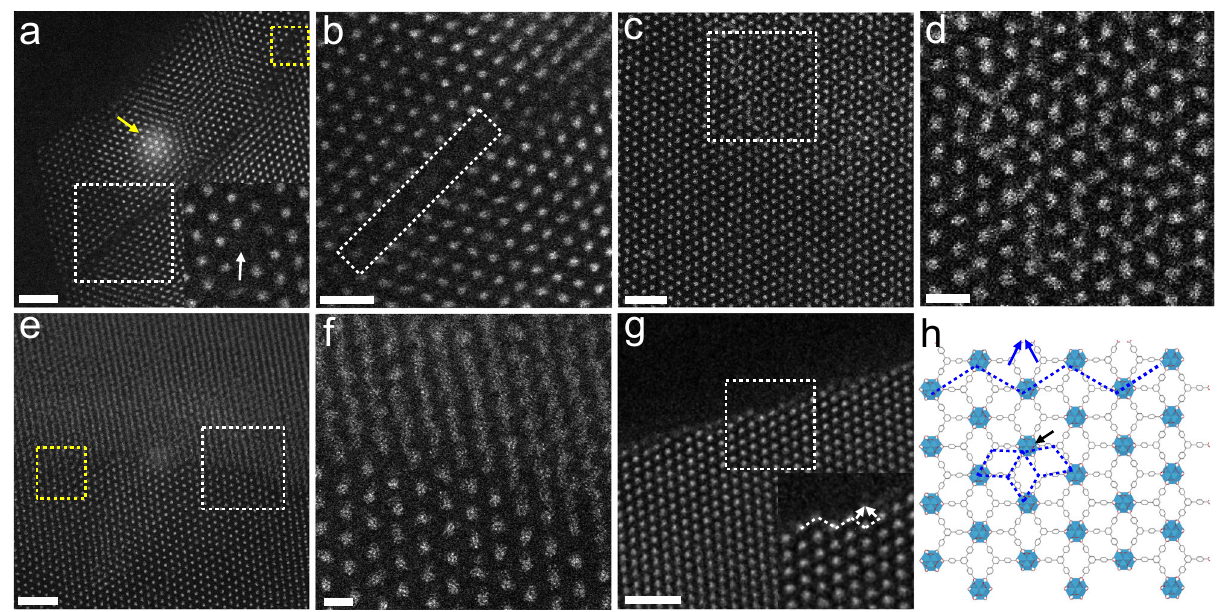
Fig. 3 | Revealing local structures of Hf-MOLs using HAADF-STEM. a HAADF- STEMimage ofMOLsshowsthemissing-clusterregions.Theinsetistheenlarged region of the yellow frame, which shows one cluster missing from the center, as indicated by the white arrow. The area indicated by the yellow arrow was caused bytheelectronbeamirradiationfor>10s. b Enlargedregionofthewhiteframein a , where a row of clusters disappeared. c HAADF-STEM image of MOLs shows connectedclustersandlocaldisorderareaswithin thebulkofHf-MOLs.Different layers of Hf-MOLs stack to form the yellow polygonal area, and some disorder structures (yellow square) are generated at the interface. d A zoomed-in area of